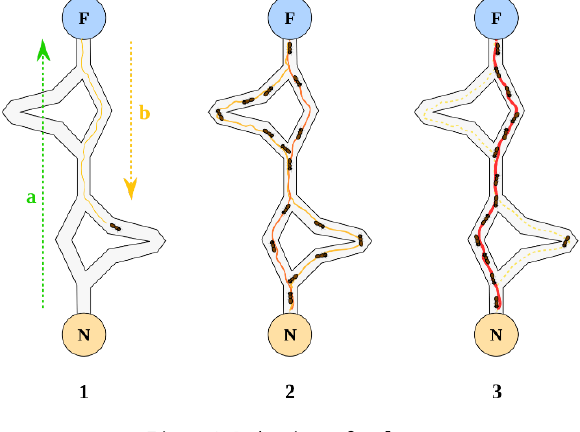
Figure 1. Behaviour of real